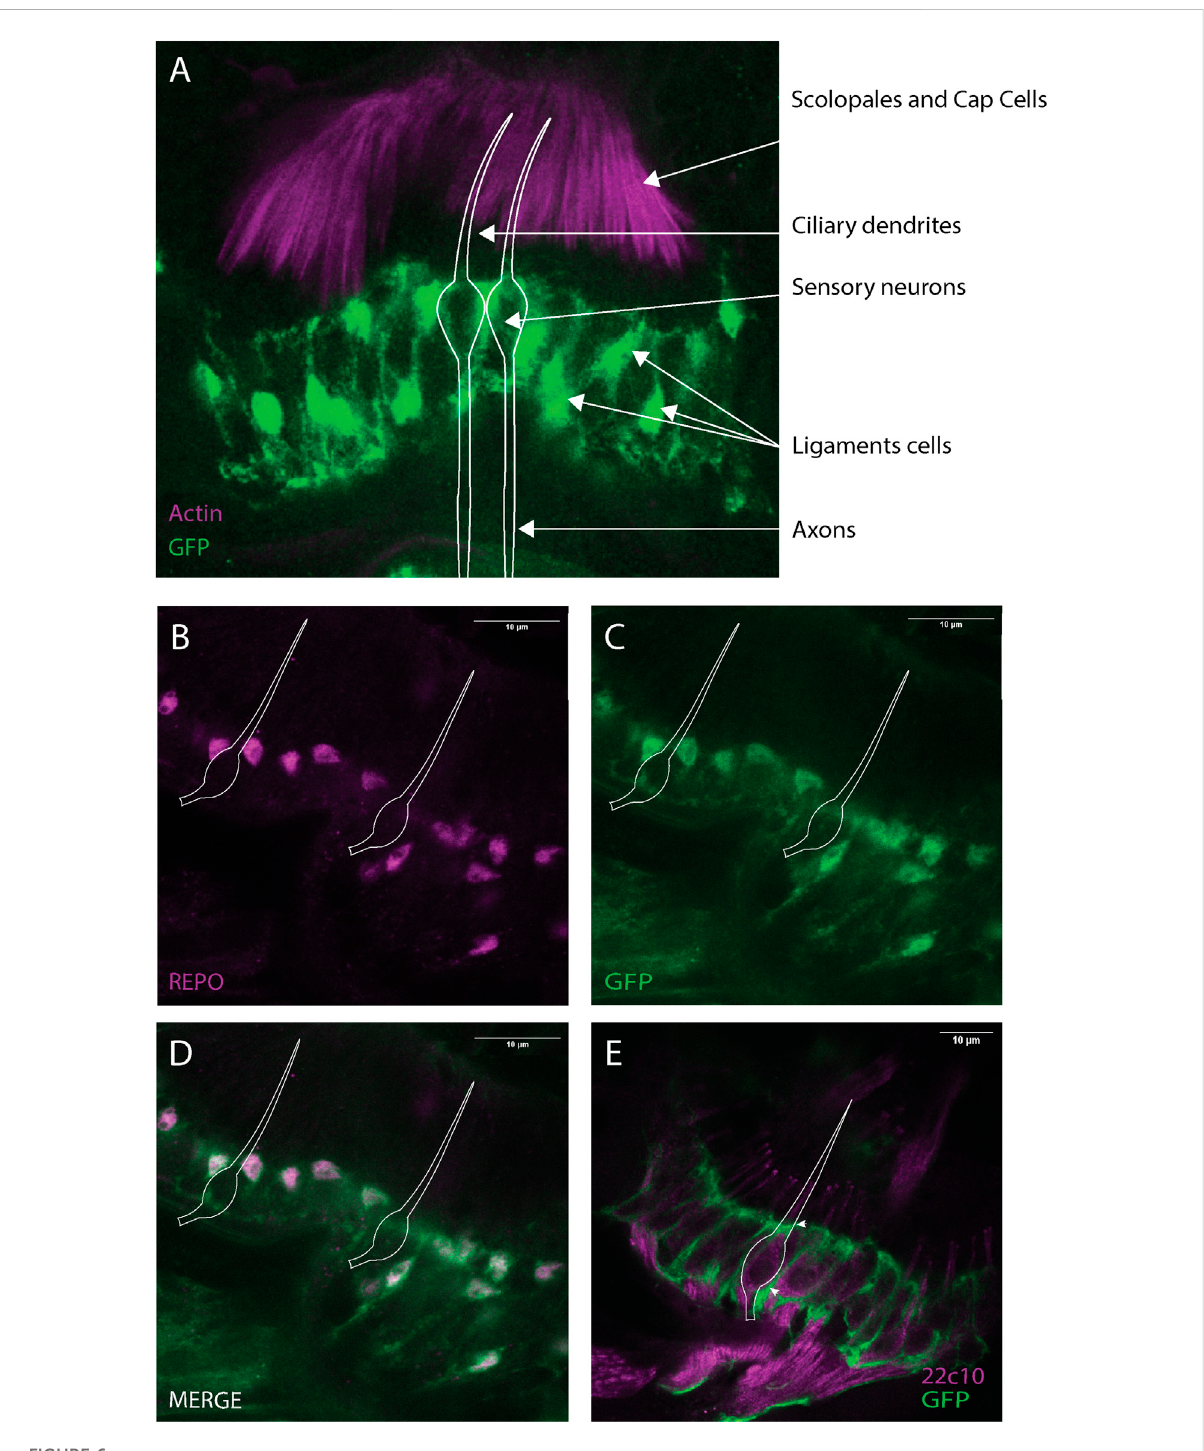
FIGURE 6 Dyb is expressed in JO, mainly in the ligament cells. Immuno fl uorescence performed on pupal antennae from the Dyb -GFP. (A) Immuno fl uorescence performed using phalloidin (marker of actin-rich scolopale, magenta) and anti-GFP antibodies (green). The expression of the Dyb -GFP reporter gene resembles the location of ligament cells ensheathing the neuronal cell bodies. The cytoplasmic GFP reveals the glia-like nature of these supporting cells. (B – D) Immuno fl uorescence performed using anti-REPO (magenta, a nuclear glia cell marker located in ligament cells) and anti-GFP antibodies(green). The co-labelling with REPO con fi rms Dyb expression in the ligament cells. (E) Immuno fl uorescence with sensory neuron marker anti-Futsch (mAb22C10, magenta), and anti-GFP (green) antibodies showing the GFP-expressing ligament cells ensheathing the neuronal cell bodies. The white diagram in all the images represents the approximate locations of example sensory neurons. Scale bars: 10 μ